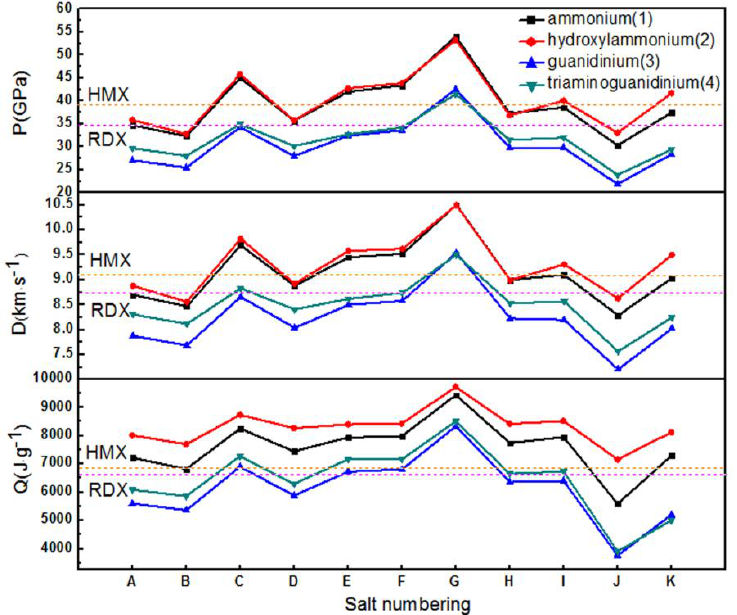
Figure 4. Comparison of the heats of detonation ( Q ), detonation velocities ( D ) and detonation pressures ( P ) of ammonium-based 4,8-dihydrodifurazano[3,4- b,e ]pyrazine-based salts. Energetic salts are expected not only to be used as explosives, but also as components in